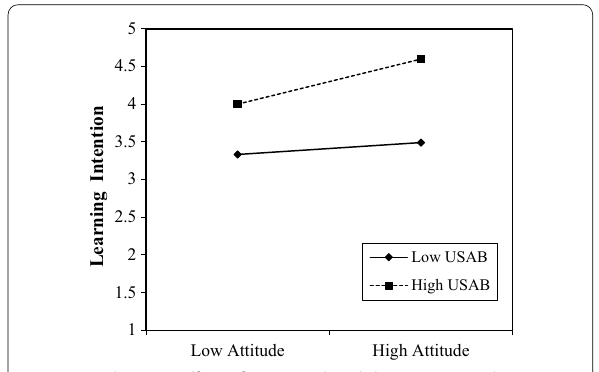
Fig. 7 Moderating effect of perceived usability (USAB) on the relationship between learning attitude and learning